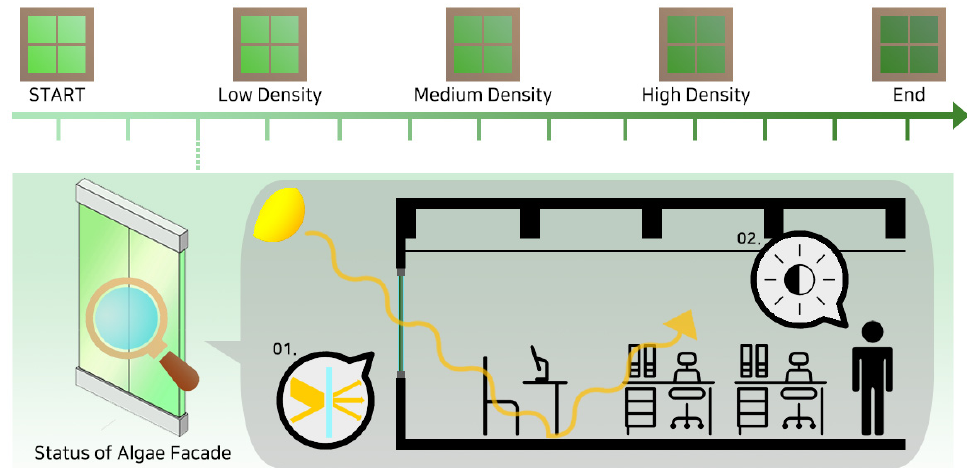
Figure 2. Mock-up test method (Adapted from Ref.